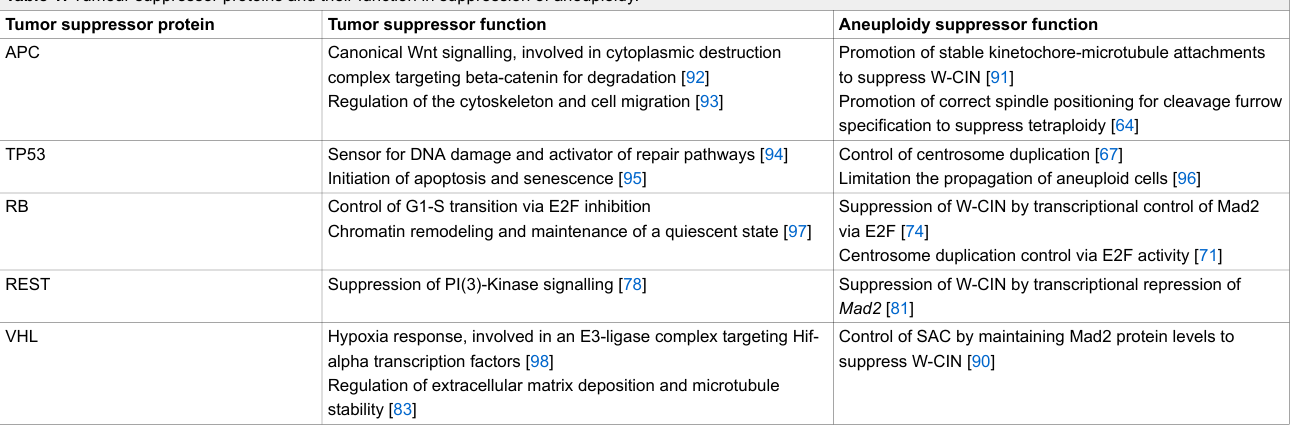
Table 1: Tumour suppressor proteins and their function in suppression of aneuploidy. Tumor suppressor protein Tumor suppressor